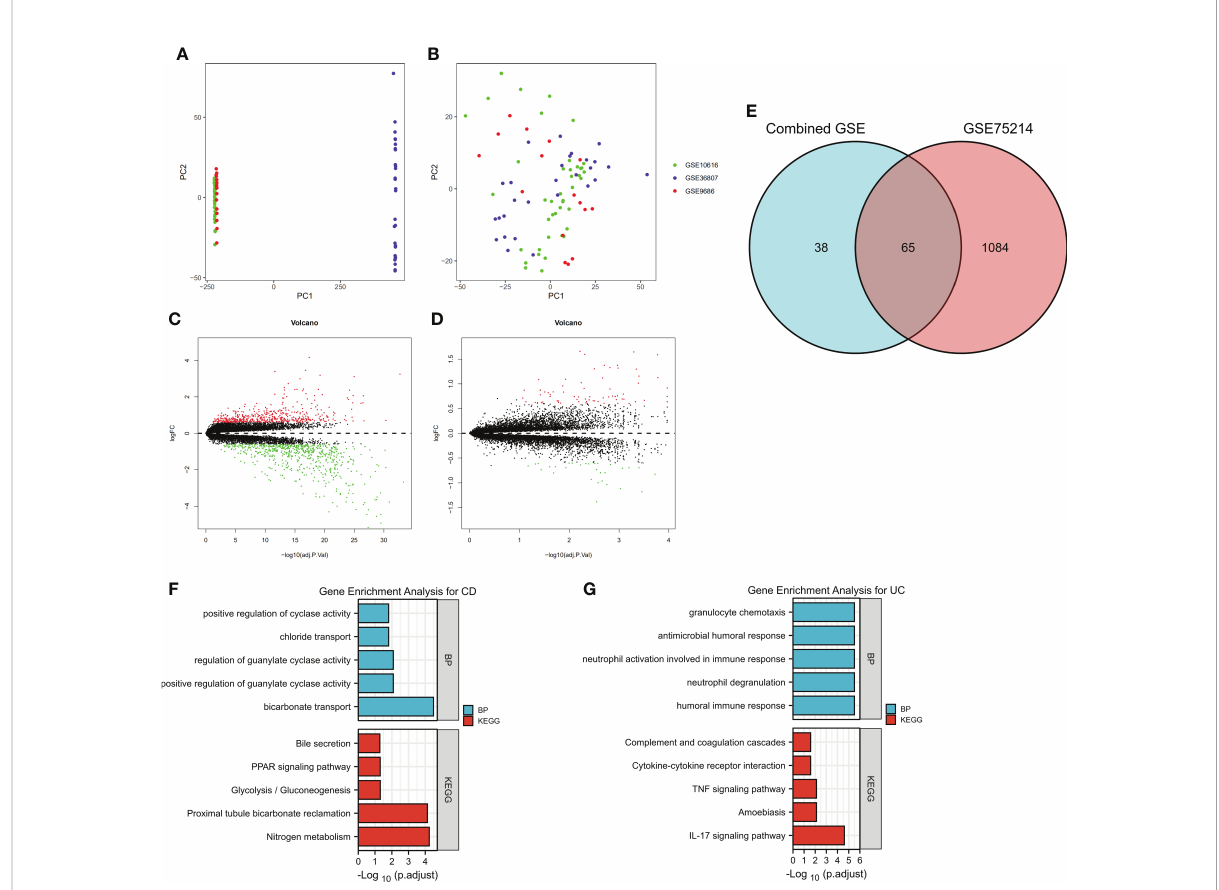
FIGURE 3 Identi fi cation of DEGs by merging and intersection and a functional enrichment analysis. The GSE10616, GSE36807 and GSE9686 datasets were merged, and batch effects were further removed. PCA plots of different datasets are illustrated before (A) and after (B) batch effects were removed. Volcano plots of the DEG distributions in the GSE75214 dataset (C) and Combined Datasets (D) . (E) The intersection of DEGs in the GSE75214 dataset and Combined Datasets is displayed as a Venn diagram. Functional enrichment analysis of DEGs, including (F) a GO-BP analysis and (G) a KEGG pathway